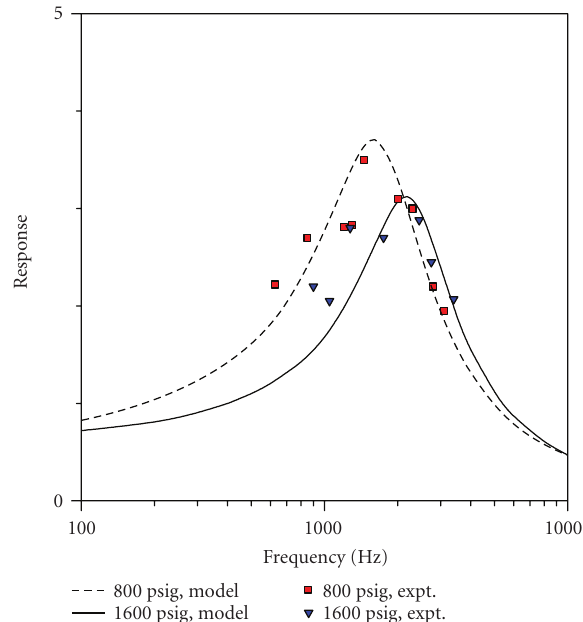
Figure 11: Frequency response of double-base Propellant E, theory ( K b = 39000 s − 1 , Δ H s = 45 000J/kg [800 psig], Δ H s = 90000 J/kg [1600 psig]) and experiment [30], in terms of real part of pressure- based